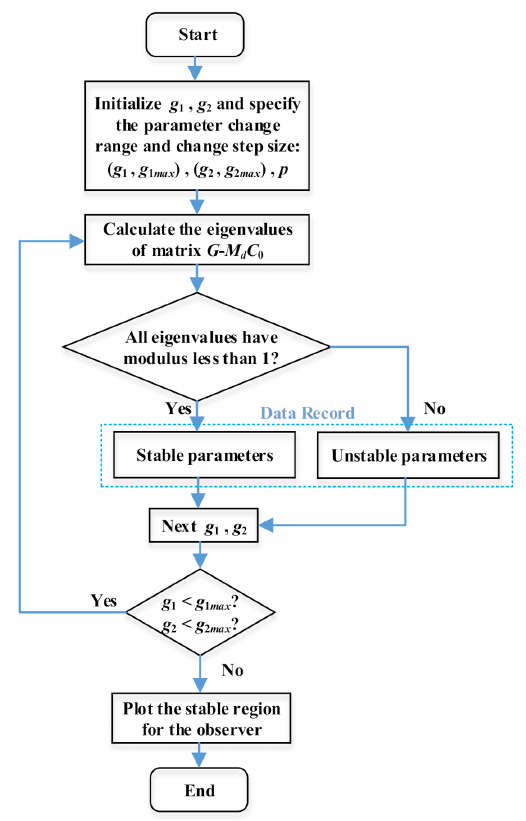
Figure 8. Flow chart for parameter scanning